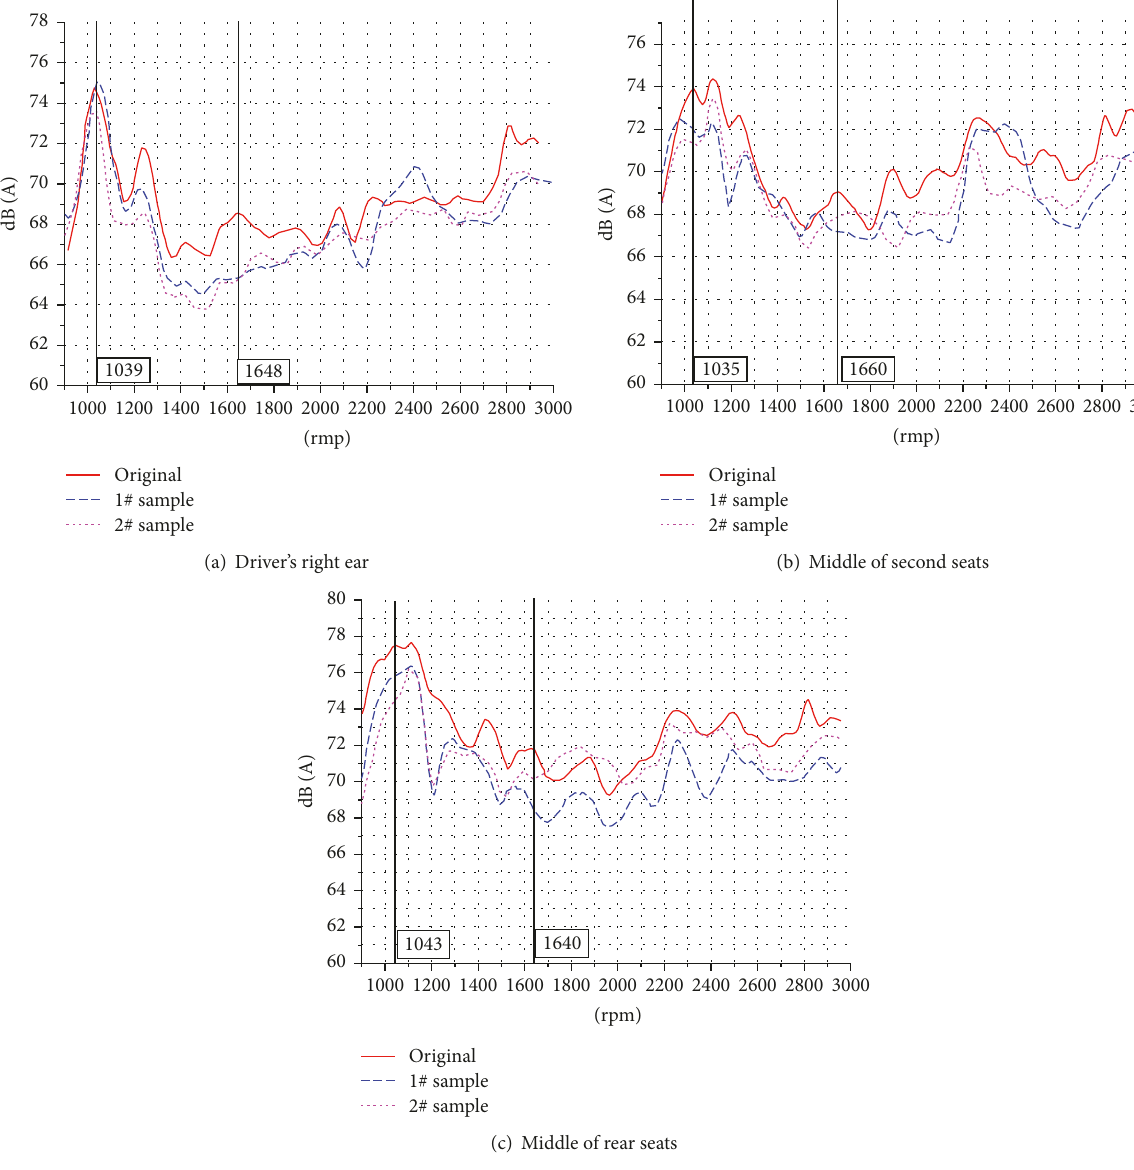
Figure 20: Interior noise